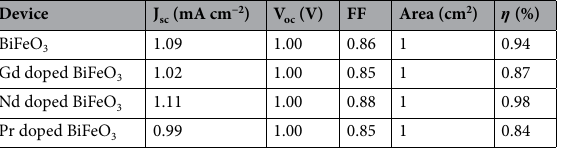
Table 3. Photovoltaic parameters of the DSSC fabricated by using malachite green dye solution.